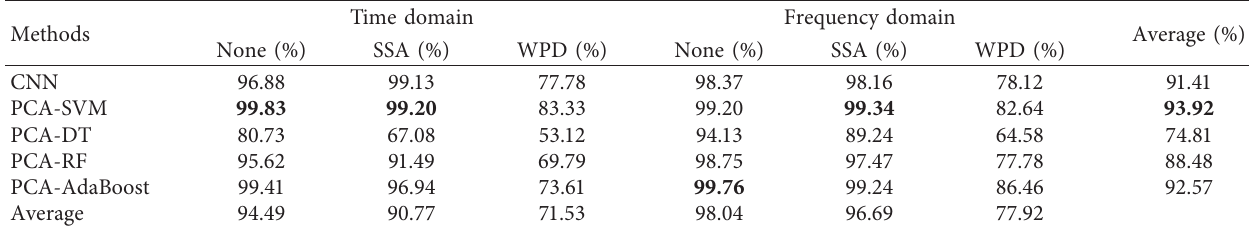
Table 3: Fault diagnosis accuracy of test set